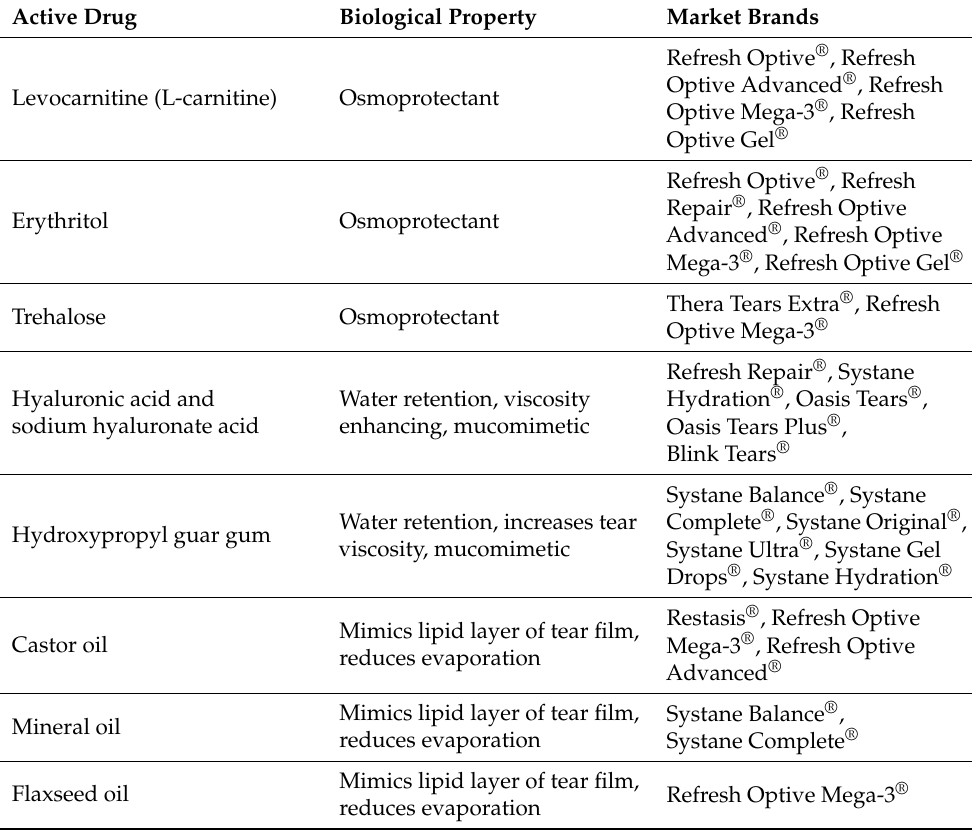
Table 2. List of other biologically active ingredients in artificial